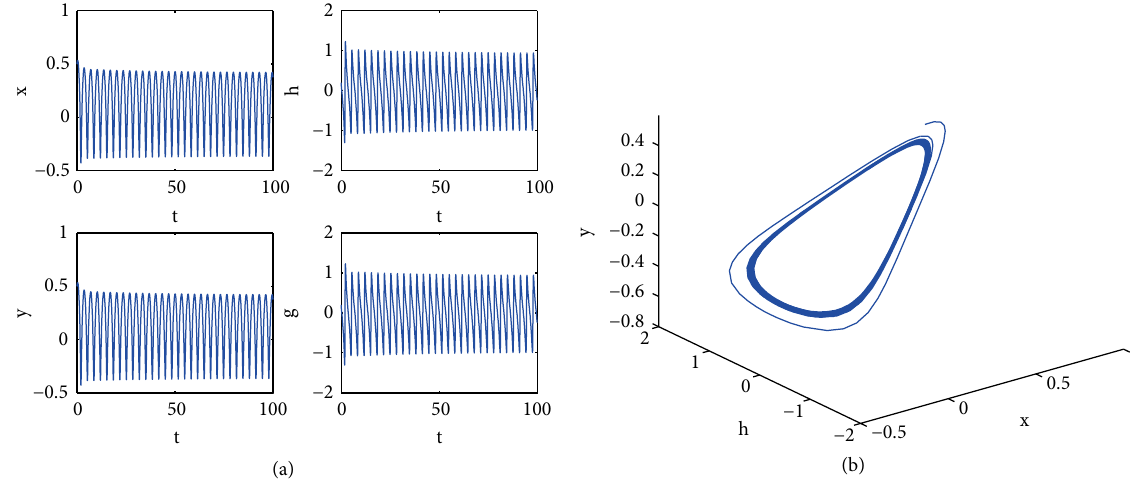
Figure 2: (a) Critical bifurcation lines in the ( 𝜀 ) parameter space near ( 𝑃 1 , 𝜀 1 plane when 𝑃 30.21, 𝜏 0.78 , (b) to embed Figure 2(a) into Figure 1, and yielding complete bifurcation sets near ( 𝑃 𝑐 = 𝑐 =